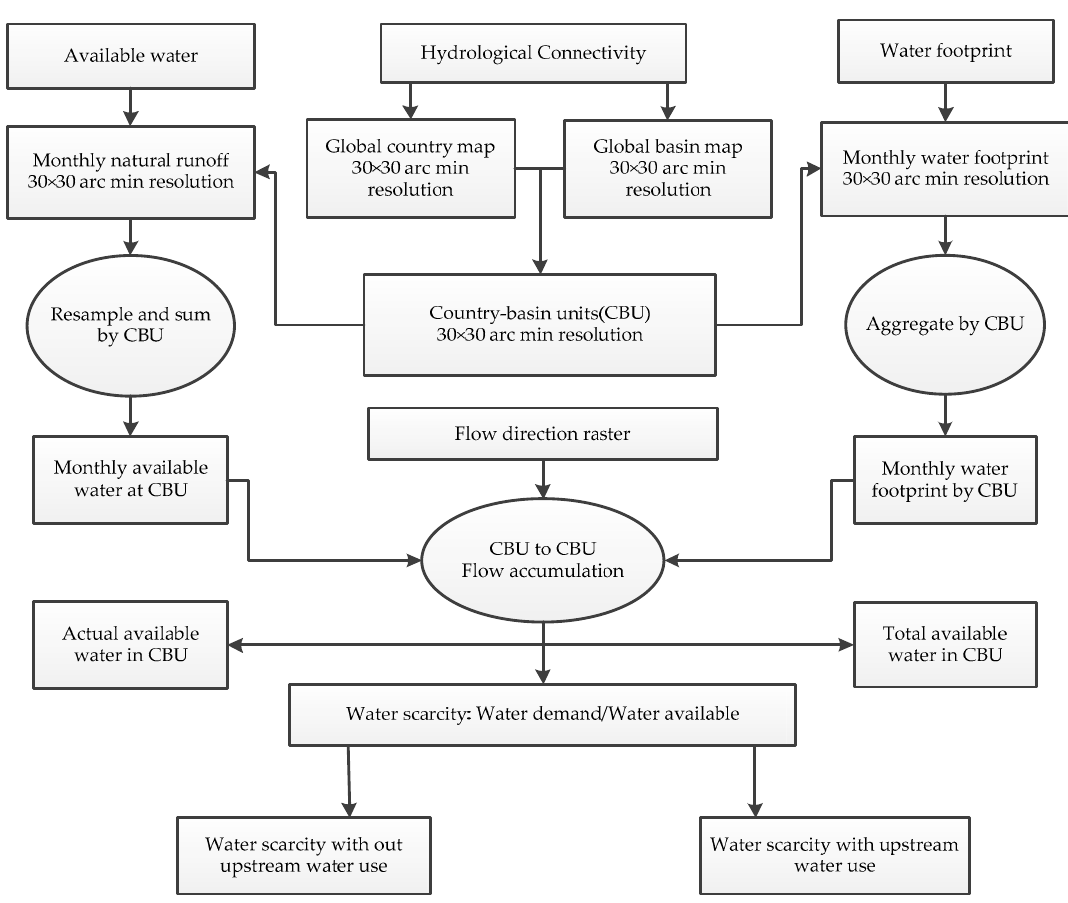
Figure 1. A methodological framework for determining the impact of upstream sub-basin water footprint on downstream sub-basin water security.